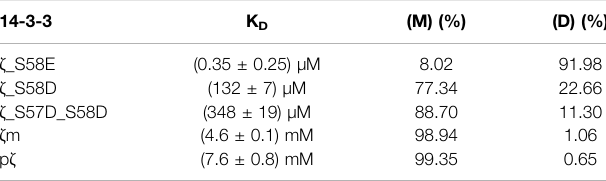
TABLE 2| Dissociation constants ofdimerization determinedfor14-3-3 ζ variants. Populations of monomers and dimers at 25 μ M concentrations are included. 14-3-3